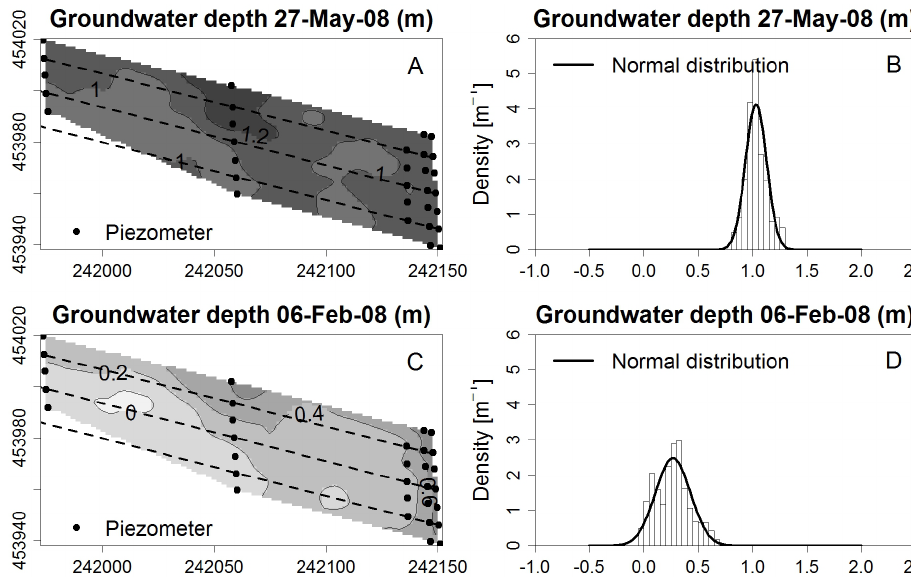
Fig. 3. Map of field-site groundwater depth for a dry (A) and a wet (C) day and the corresponding groundwater depth distributions ( B and D ).